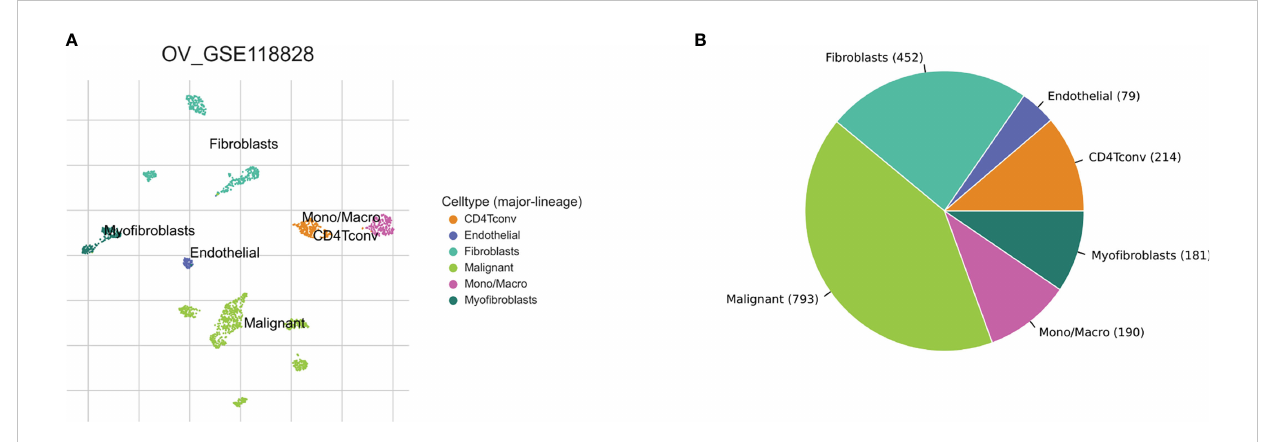
FIGURE 2 Ovary cancer single-cell data analysis based on the GSE118828 dataset. (A) The UMAP plots with cells coloured by cell type were displayed. (B) The pie plot showed the cell number distribution of each cell type.